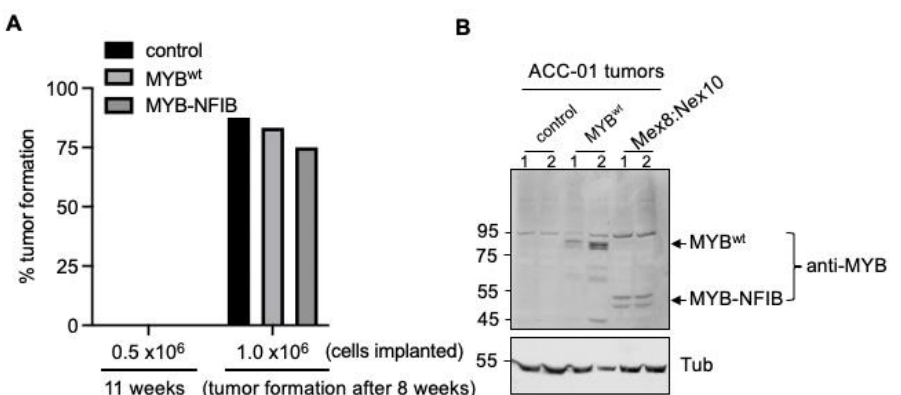
Figure 6. In vivo tumor growth analysis of MYB-NFIB fusion expressing ACC-01 cells. ( A ), Mice were implanted subcutaneously with parental or stable cell lines of FLAG-tagged MYB wt or MYB-NFIB fusion constructs as indicated ( n = 6–8 each group). Mice were fed with dox containing drinking water. Tumor growth was then assessed up to 11 weeks. Palpable development of tumor at the end of 8 weeks was considered positive tumor growth. ( B ), Protein extracts from two representative tumors of each group were analyzed for MYB wt or MYB-NFIB fusion expression by immunoblotting. In mice implanted with 1.0 × 10 6 cells, palpable tumors were formed in parental (3/8), MYB-NFIB fusion (1/6) and MYB wt (1/6) at about 5.2 weeks. And by the end of 8 weeks,